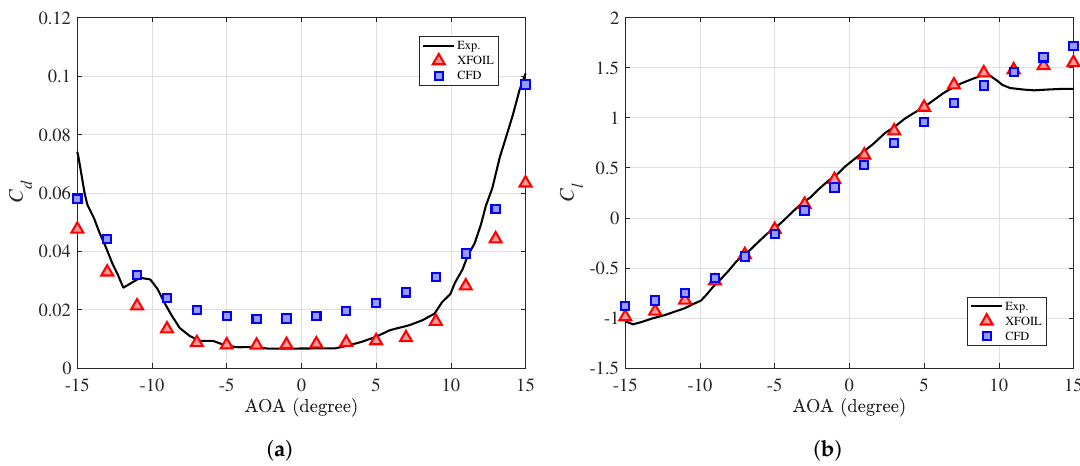
Figure 2. The data obtained from the experiment, XFOIL and CFD are compared with the drag coefficient in ( a ) and the lift coefficient in ( b ) at the angles of attack from − 15 ◦ to 15 ◦